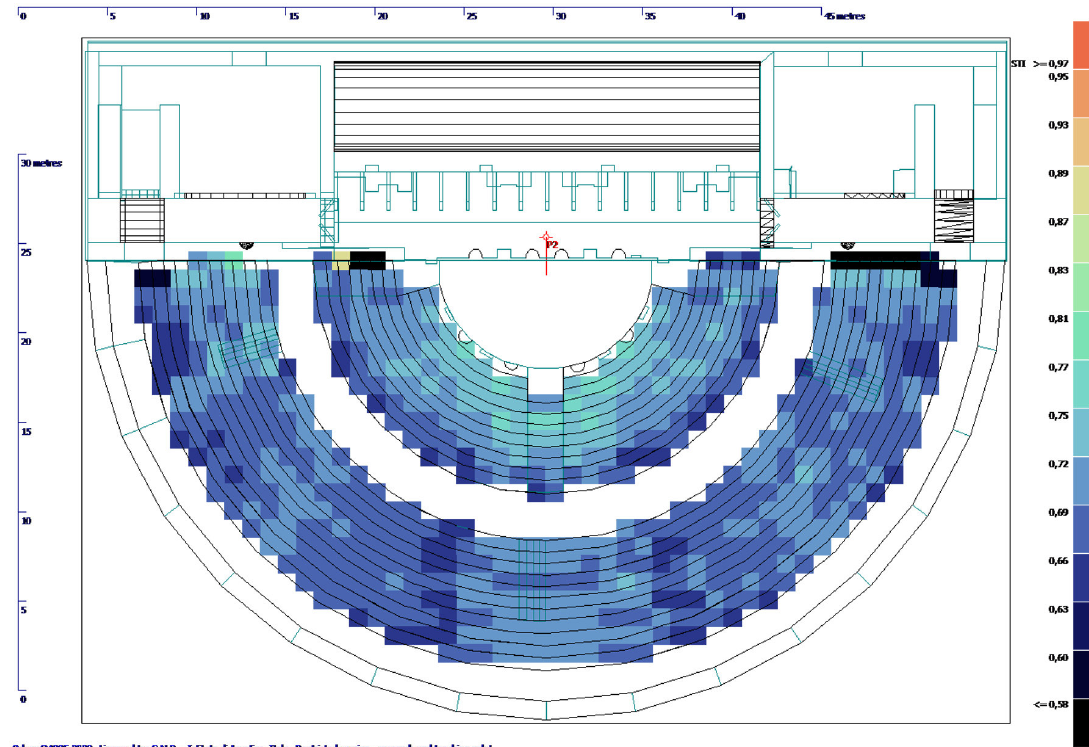
Figure 4. Grid of distribution of the values of